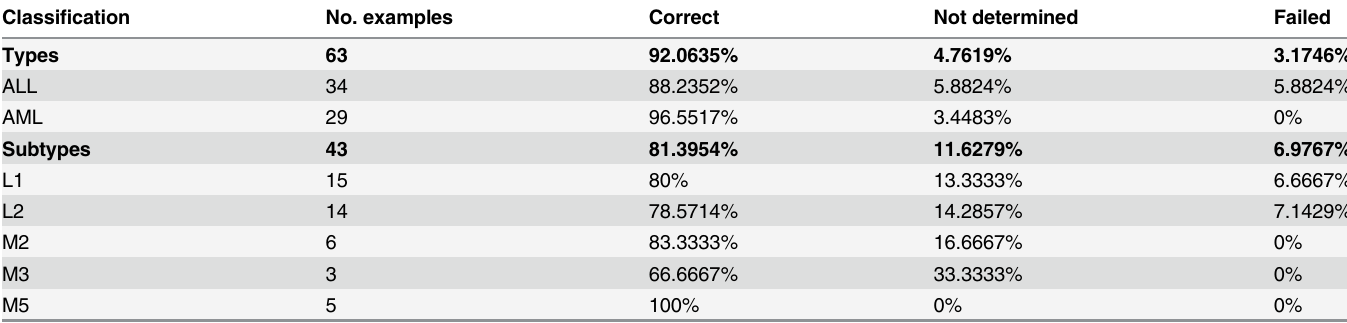
Table 6. Evaluation of the acute leukemia diagnosis algorithm by merging binary classifiers results. Classi fi cation